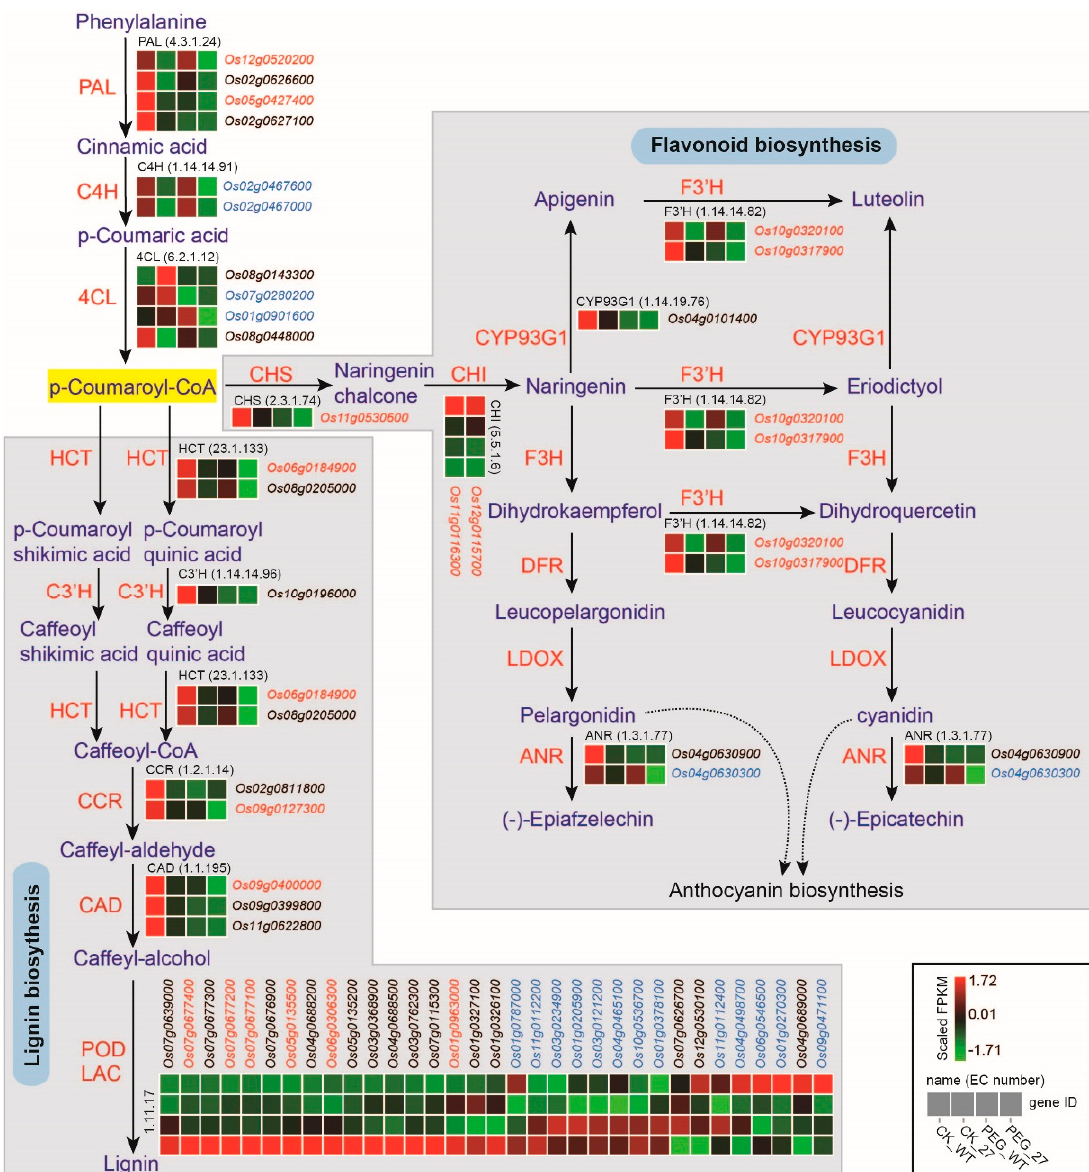
Figure 6. Differentially expressed genes in phenylpropane biosynthesis pathway including lignin biosynthesis and flavonoid biosynthesis. DEGs under normal conditions are shown in black. DEGs under PEG6000 treatment are shown in blue. DEGs under both conditions are shown in red. The